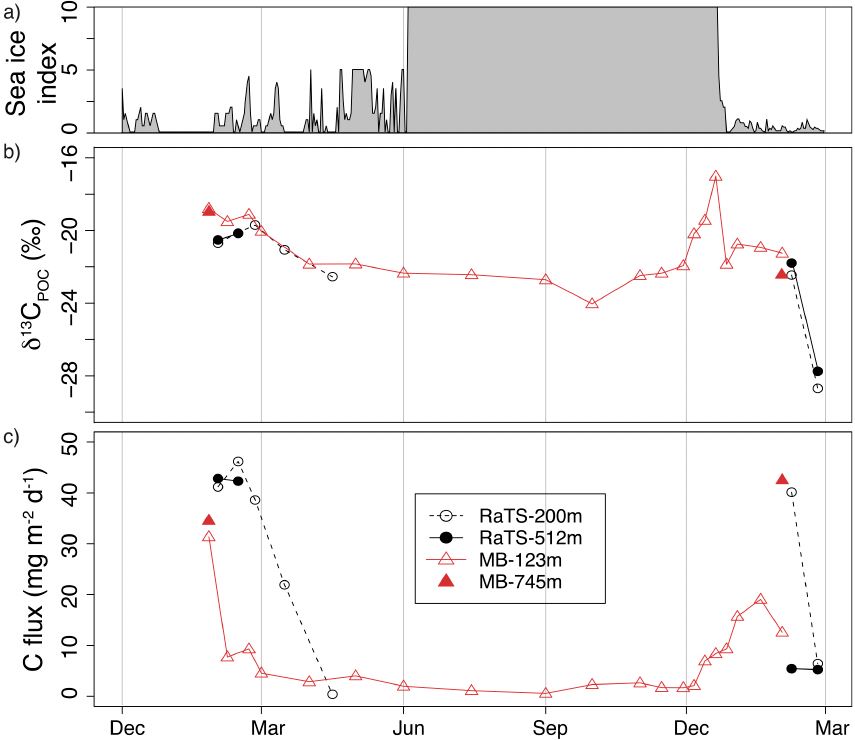
Fig. 7. δ 13 C POC and carbon (C) flux data from time-series sediment traps from December 2004 until March 2006, as per legend. RaTS is the trap mooring at the routine sampling site in Ryder Bay, MB is the deeper trap mooring in Marguerite Bay. The top panel shows sea ice coverage as measured daily in Ryder Bay (data from the British Antarctic Survey). Maximum error on sediment trap δ 13 C POC values is 1.0‰ associated with formaldehyde preservation (Mincks et al., 2008) since this vastly exceeds analytical error.